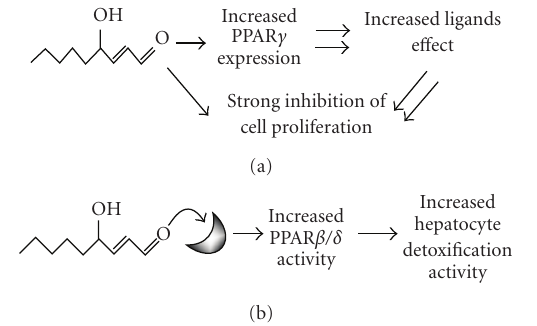
Figure 2: Di ff erent interactions between HNE and PPAR. (a) HNE increases PPAR γ expression in leukemic cell lines; (b) HNE binds and activates PPAR β / δ